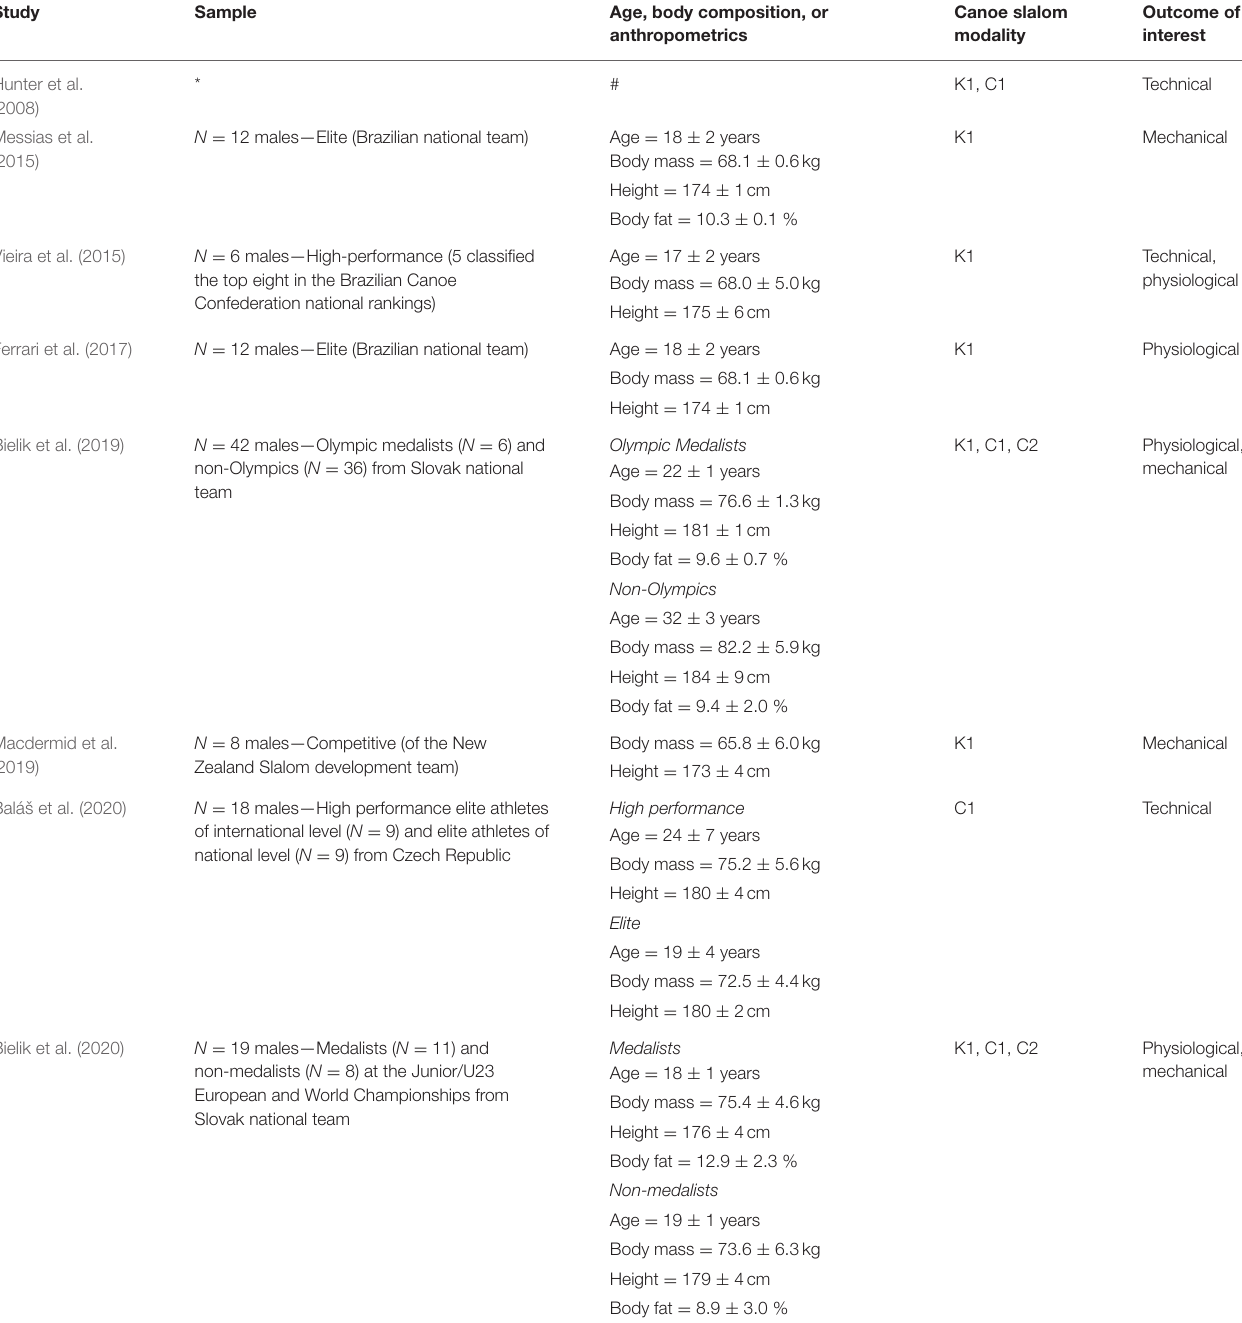
TABLE 1 | Characteristics of the eligible studies. Study Sample Age, body composition, or